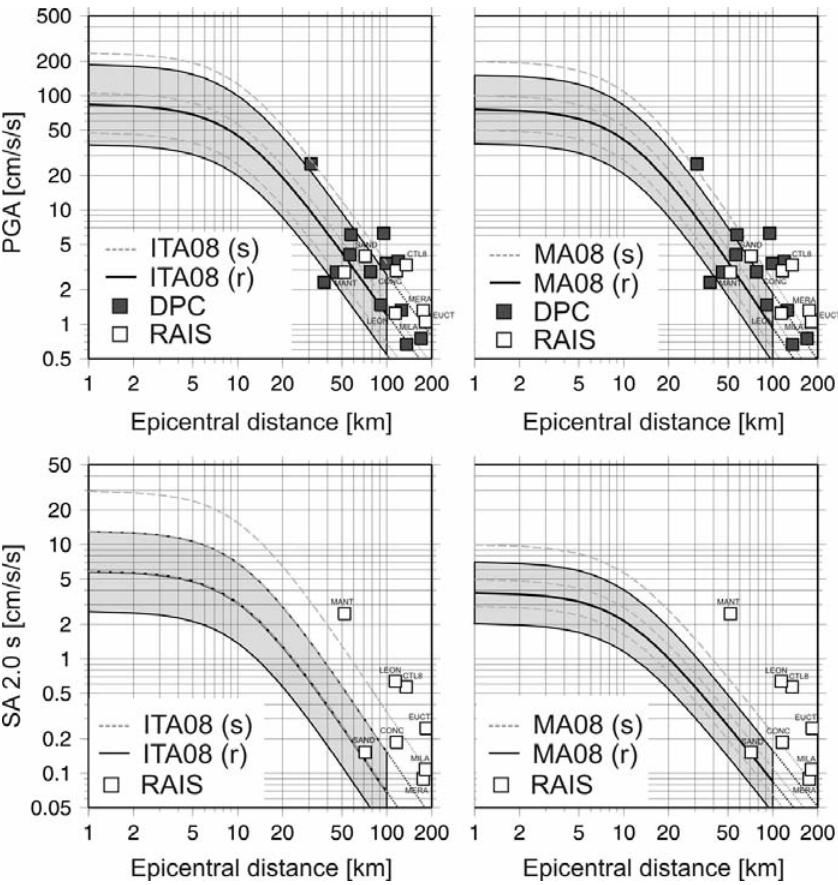
Figure 4. Comparisons between the recorded PGA (top) and SA at 2.0 s (bottom) related to the July 17, 2011 event (considering the maximum horizontal component) and the empirical GMPEs available for the area. Left: Comparisons considering the Italian GMPEs calibrated by Bindi et al. [2010] (ITA08). Right: Comparisons considering the regional relationships calibrated by Massa et al. [2008] (MA08). Solid black lines, dashed grey lines, models (median ±1 v ) calibrated for hard rock and soft soil, respectively. For both empirical models, the explanatory variable for distance was valid up to 100 km, and was extrapolated up to 200 km. Labels for the RAIS stations are